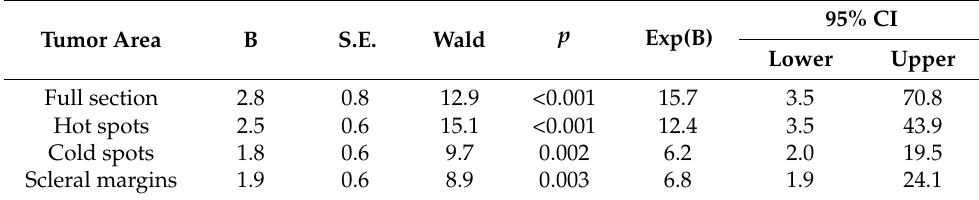
Table 3. Univariate Cox regressions, hazard for metastasis per BAP-1 status high or low in each tumor region. S.E., standard error. C.I., confidence interval. Tumor Area